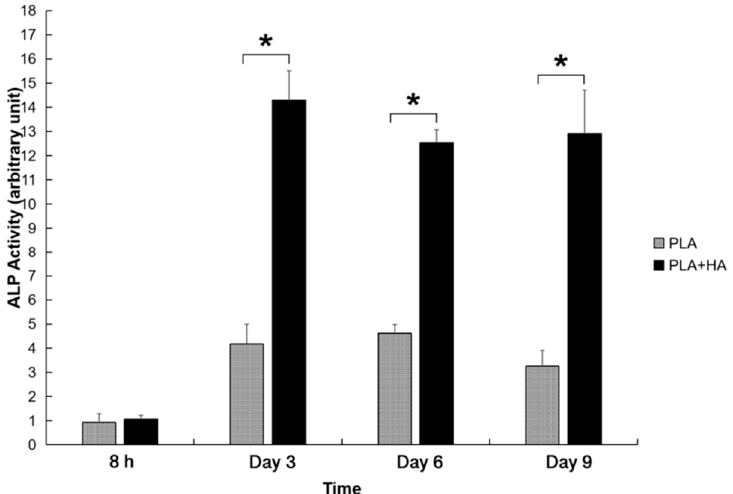
Figure 7. HA-incorporated scaffold demonstrated significantly higher osteoinductivity than PLA only scaffold as demonstrated by the Alkaline-Phosphatase (ALP) activity. * indicates p < 0.01.